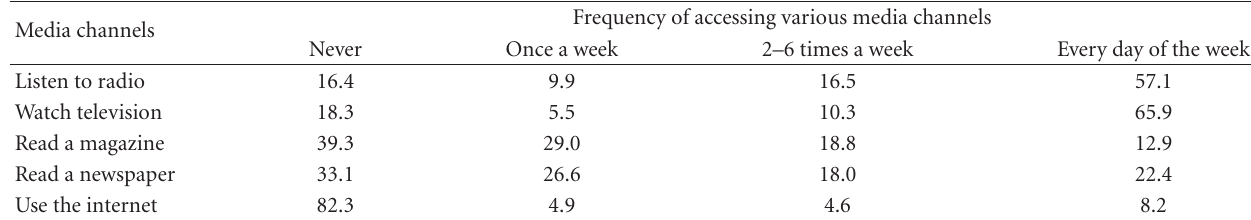
Table 1: Percentage of people accessing various media